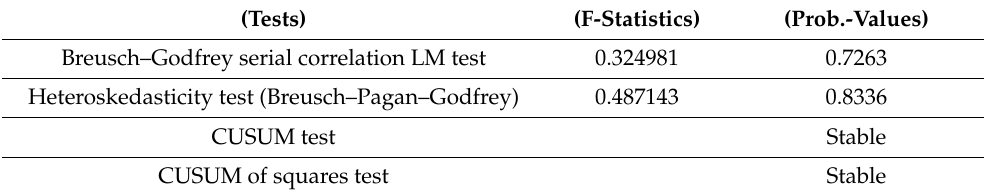
Table 9. Results of stability and diagnostic tests.